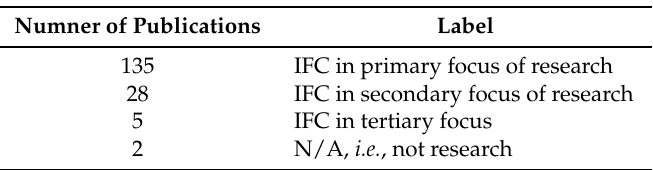
Table 7. Frequency ranking of publications by IFC